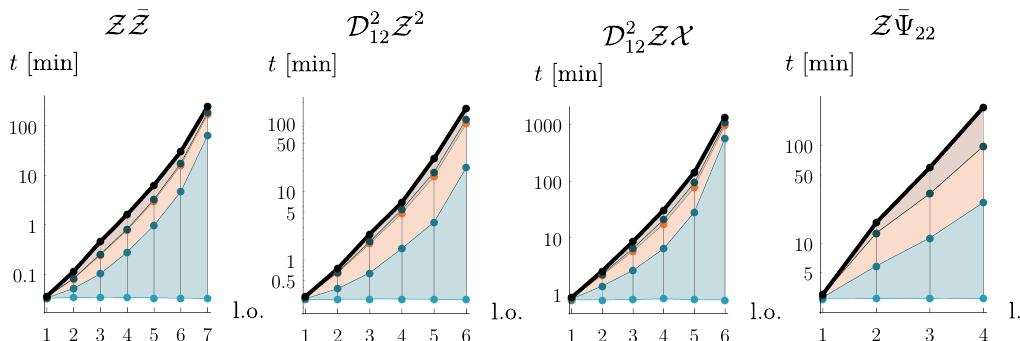
Figure 8 . The scaling of computation times for four example operators: the Z (cid:22) Z which has no twist, p the simple D 2 Z 2 , the D 2 ZX which contains 6 and Z (cid:22)(cid:9) 22 which contains the more complicated 12 12 p square root x (2 x 2 + 5 x + 2). The total computation time is plotted as the thick black line in accordance with the logarithmic time scale on the y -axis. The shaded regions below that line indicate the fractional computation times (in percent) spent at each step in the algorithm and are hence independent of the scale on the axis. The step coloration follows section 5.1 as in step 1 (which is almost instant), step 2, step 3, step 4 and step 5. Note how the computation times increase signi(cid:12)cantly with the presence of the square